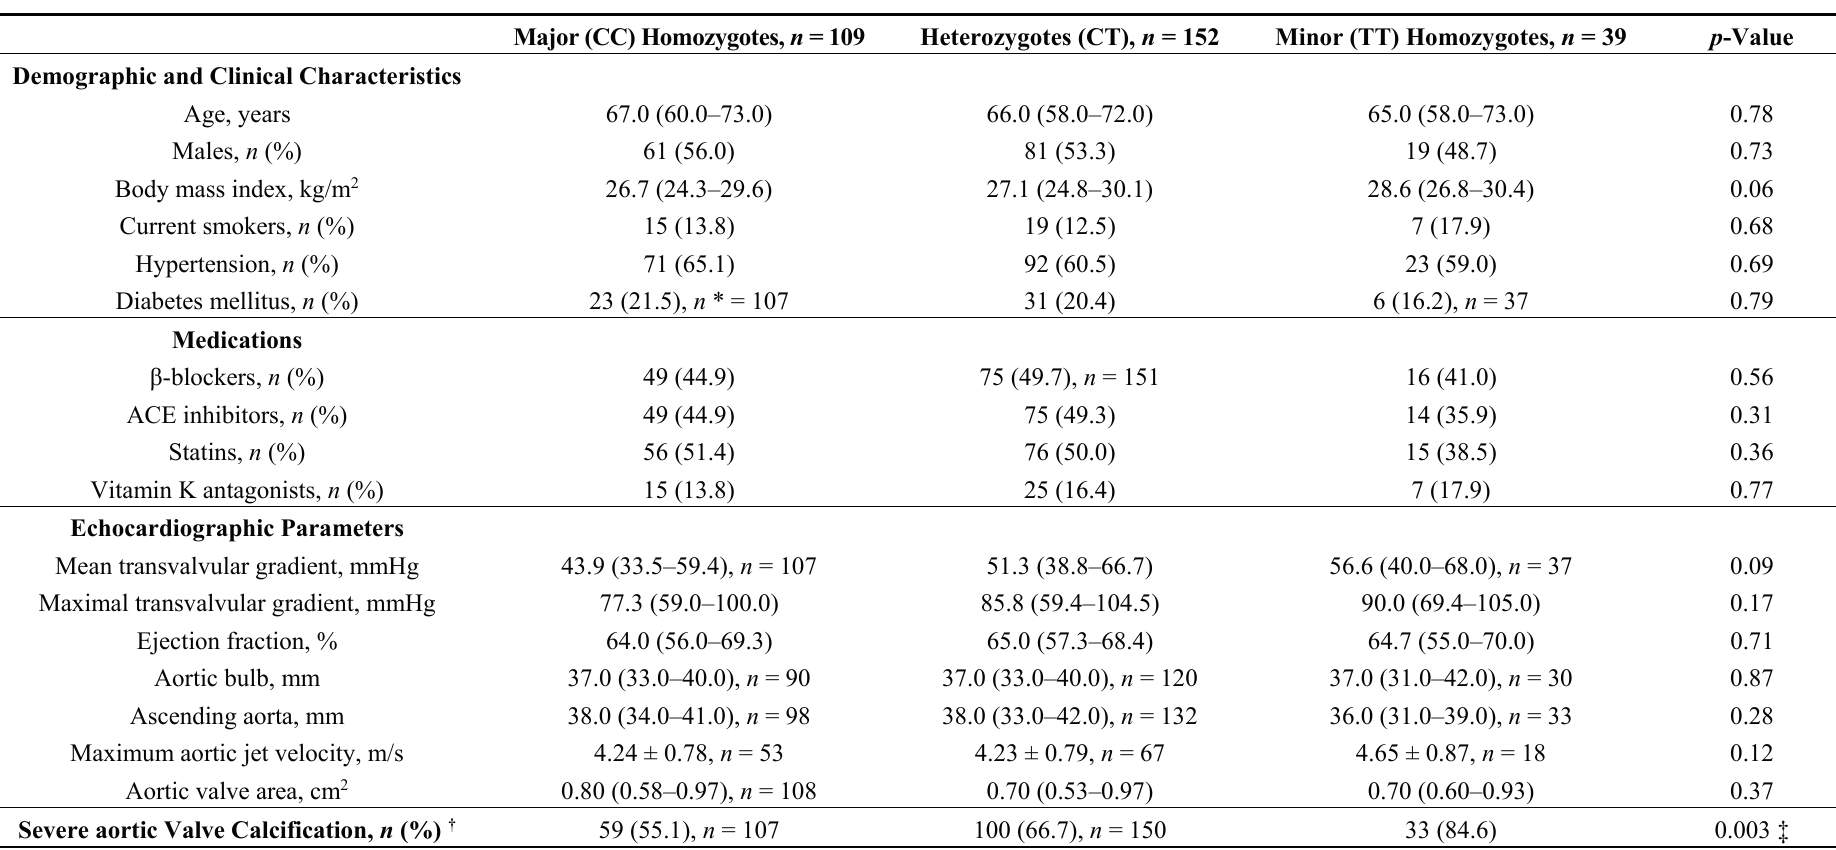
Table 1. Demographic, clinical and laboratory characteristics of 300 aortic valve stenosis patients with regard to the C-reactive protein ( CRP ) gene rs1205 C>T